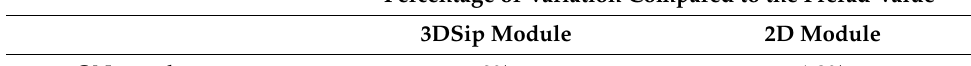
Table 2. Percentage of variation compared to the prerad value of parameters at 118 Krad(Si) (Co 60